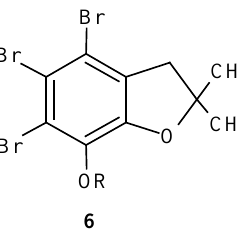
Figure 4. The general structure 6 of 1-(3-amino-2-hydroxypropyl) derivatives of 4,5,6- tribromo-2,3-dihydro-2,2-dimethyl-7-benzofuranol.